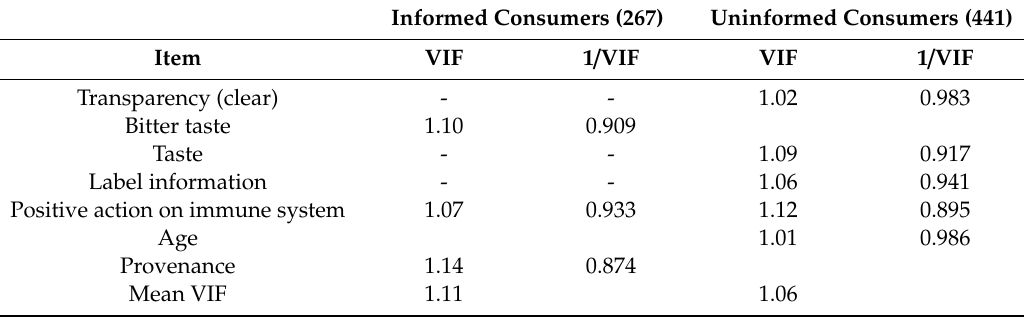
Table 6. Variance inflation factor (VIF) analysis performed for both logit models: informed and